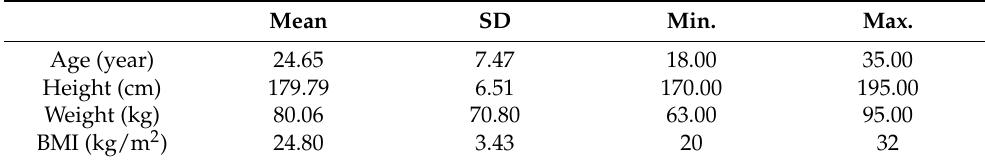
Table 1. Descriptive data of the